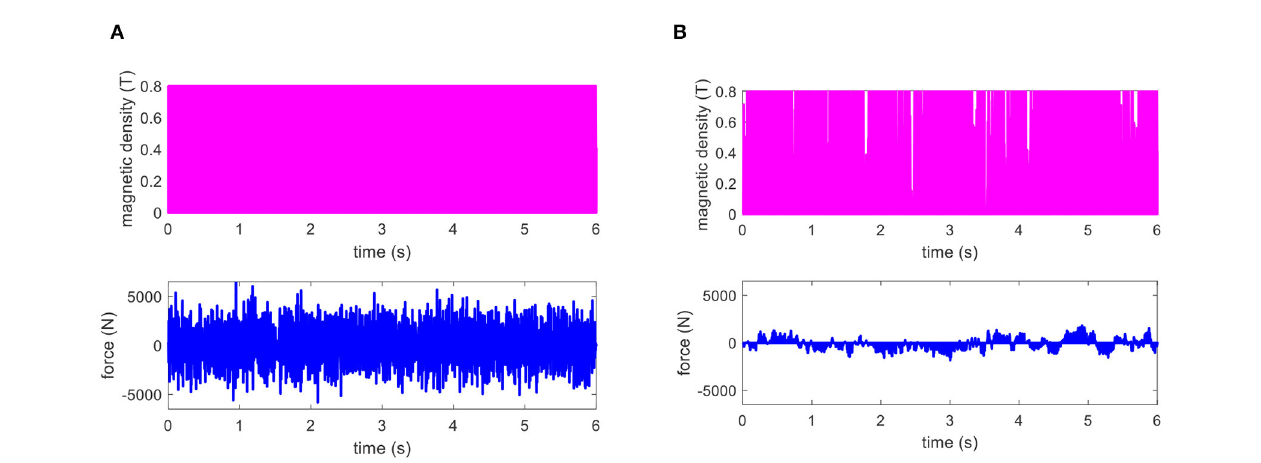
FIGURE 13 | The control input to the MRE-based isolator for random excitation; (A) ON-OFF controller, and (B) adaptive NN